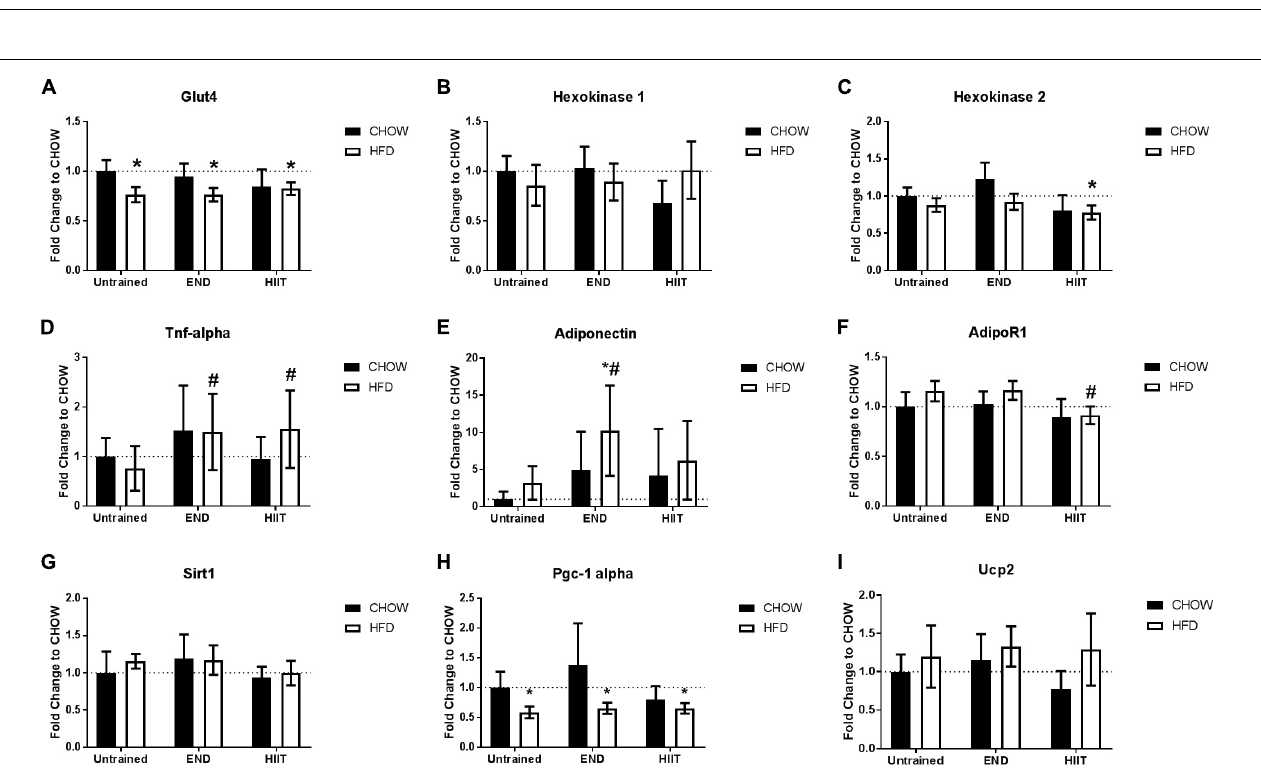
FIGURE 3 | Skeletal muscle mRNA levels for glucose uptake and metabolism related genes. Glut4 receptors (A) , Hexokinase 1 (B) , and 2 (C) , Tnf (D) , muscle adiponectin (E) , adiponectin receptor 1 (AdipoR1; F ), sirtuin 1 (Sirt1; G ), peroxisome proliferator-activated receptor gamma coactivator 1-alpha (Pgc-1 alpha; H ), and uncoupling protein 2 (Ucp2; I ). Data are presented as mean ± SD with n = 10–12 animals per group. ∗ p < 0.05 vs. CHOW untrained; # p < 0.05 vs. HFD untrained by Two-way ANOVA with Tukey’s and Sidak’s post hoc tests.